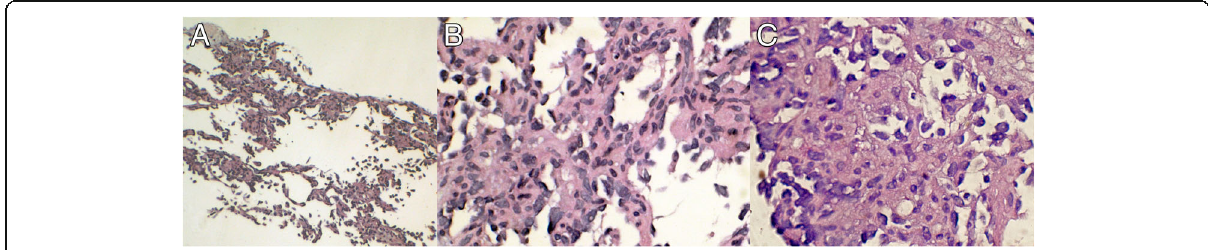
Fig. 7 Histopathological features. a Fragment of tumor biopsy. Magnification × ;40. b and c Fragment of mesenchymal neoplasia exhibiting proliferation of atypical epithelioid cells with solid pattern and lining irregular vascular channels and papillary structures. Magnification ×